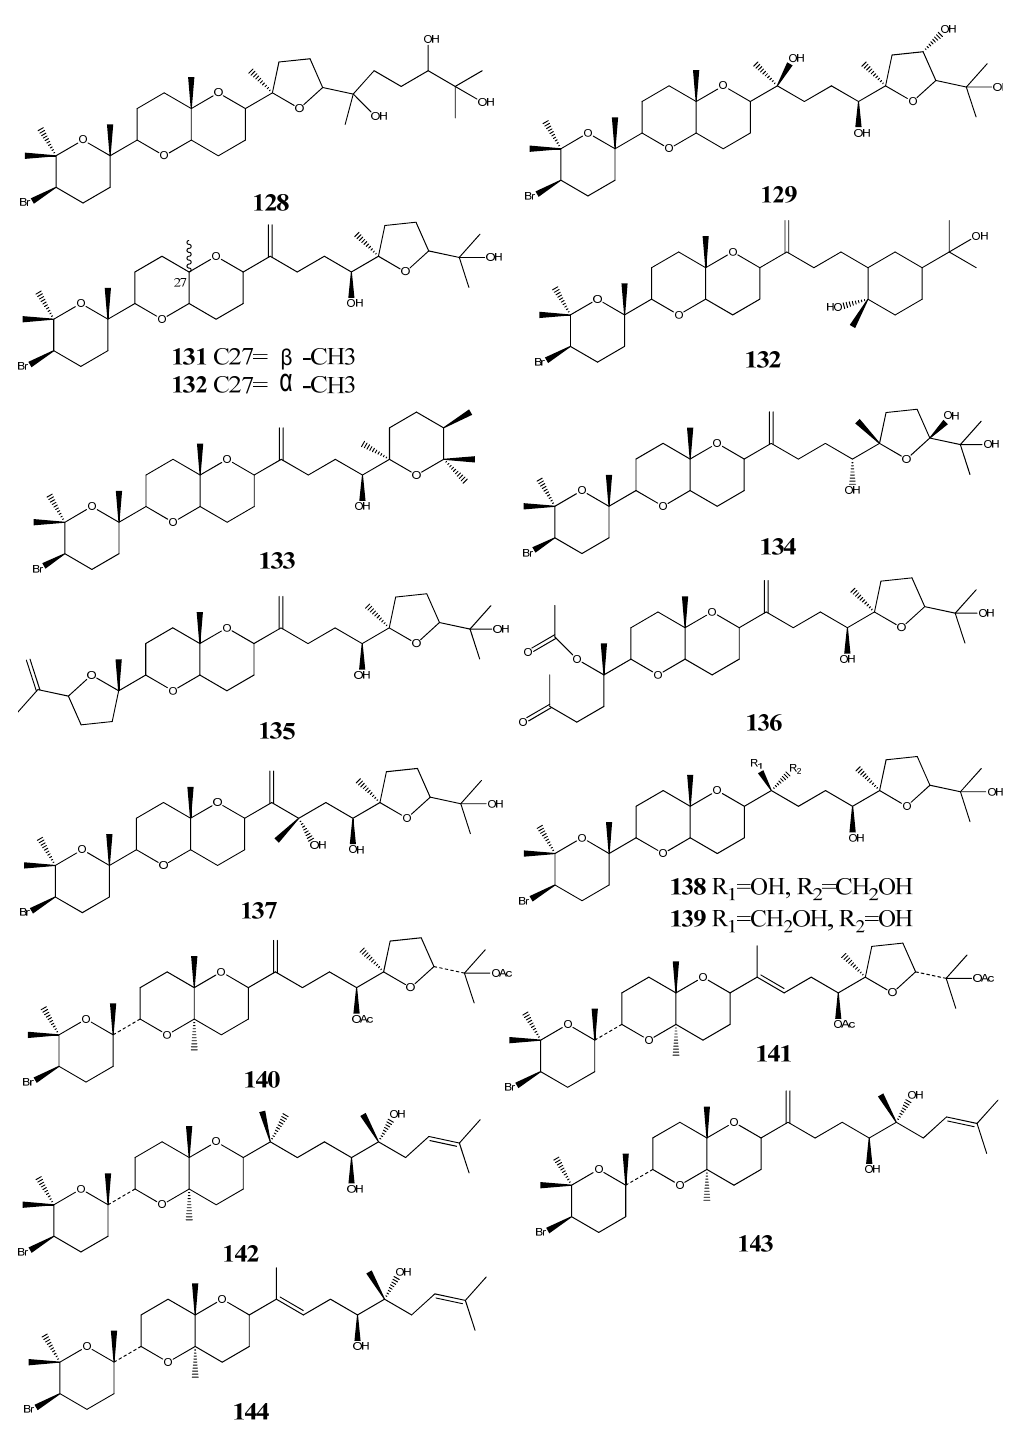
Figure 18. Squalenoid-derived triterpenoids from marine